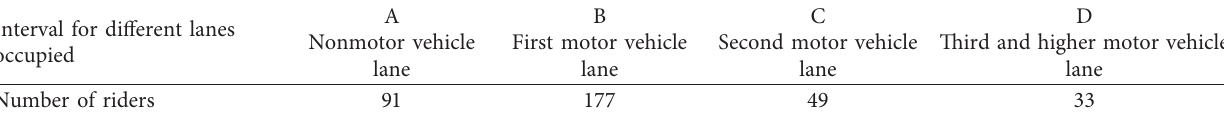
Table 5: Lanes illegally occupied by e-bike